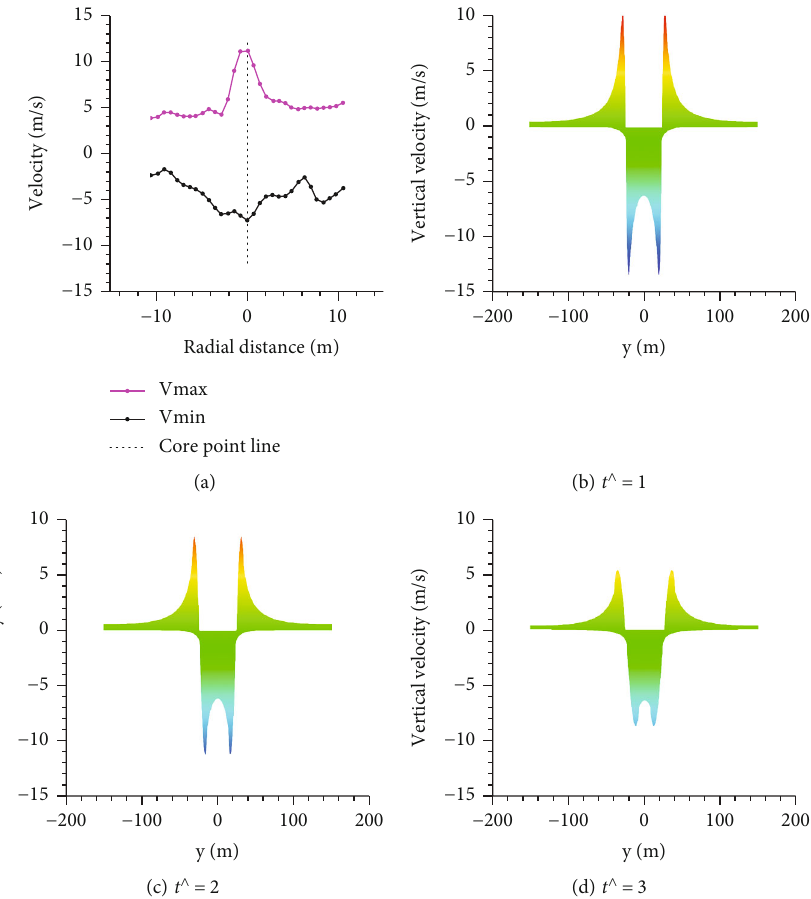
Figure 9: Wake vortex velocity distribution: (a) radar measurement result and (b – d) numerical simulation results.